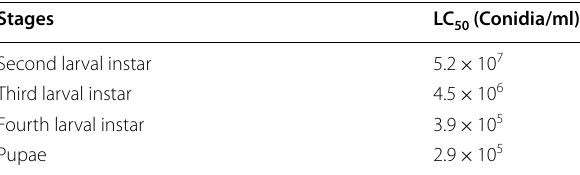
Table 5 Lethal concentration (LC against larval and pupal stages of Tuta absoluta after seven days of fungal